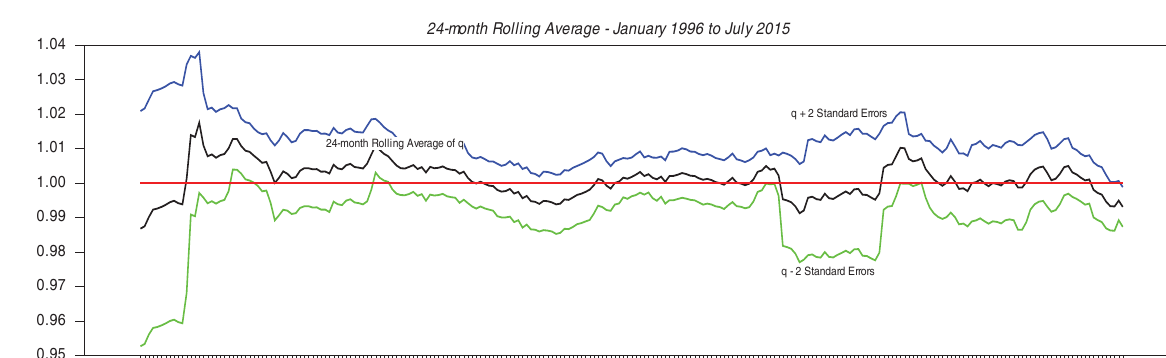
Fig. 10. Mexican peso-U.S. dollar real exchange rate